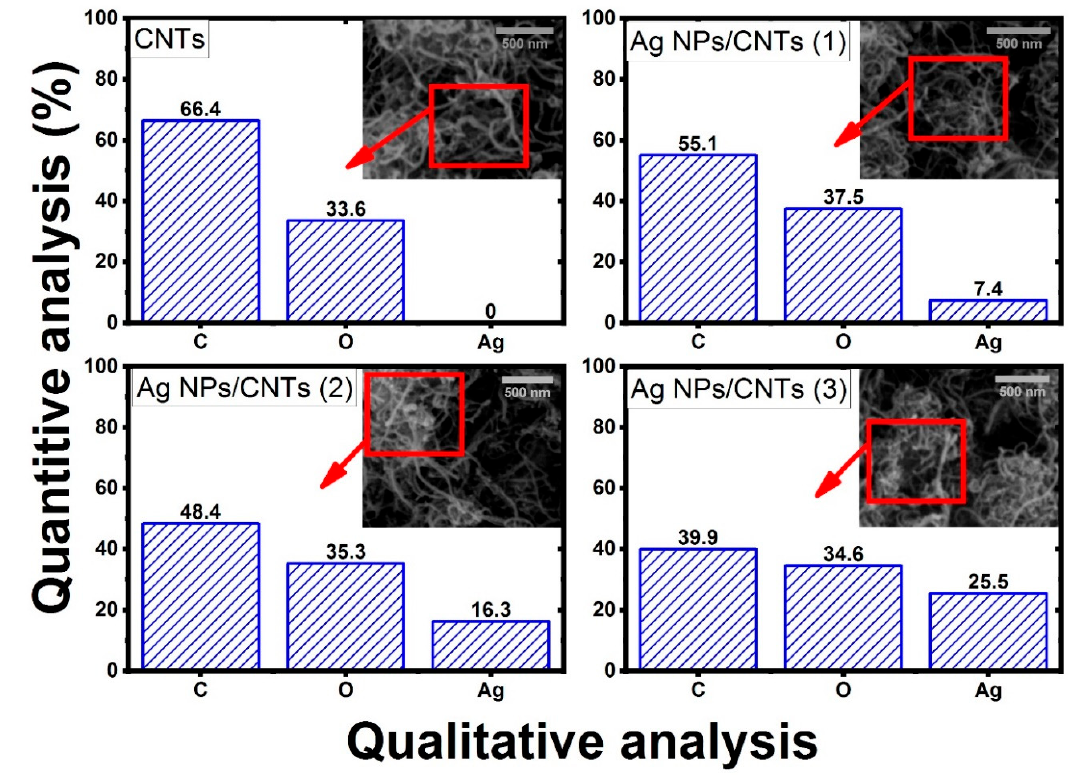
Figure 5. The SEM images and elemental analysis of the functionalized CNTs and their decoration by Ag NPs with different concentration based on tuning laser ablation time.